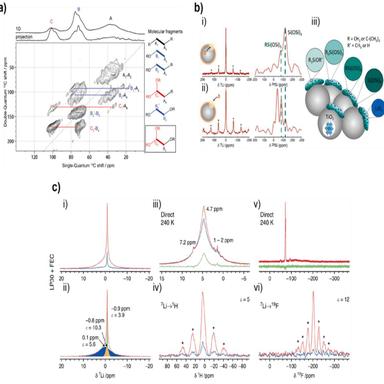
.2. (a) DNP-enhanced 2D SQ/DQ 13C-13C POST-C7 dipolar correlation spectrum of Si anode cycled for 100 cycles with FEC. The molecular fragments of the polymeric species in the SEI, as determined from the correlations in the spectrum, are also shown; (b) i) endogenous and ii) exogenous DNP-enhanced 7 Li and 19F SSNMR spectra of LixSiyOz coated Fe-doped TiO2 anode materials. iii) Representation of the structure model for the LixSiyOz coating layer showing the various silicon environments as different shades of